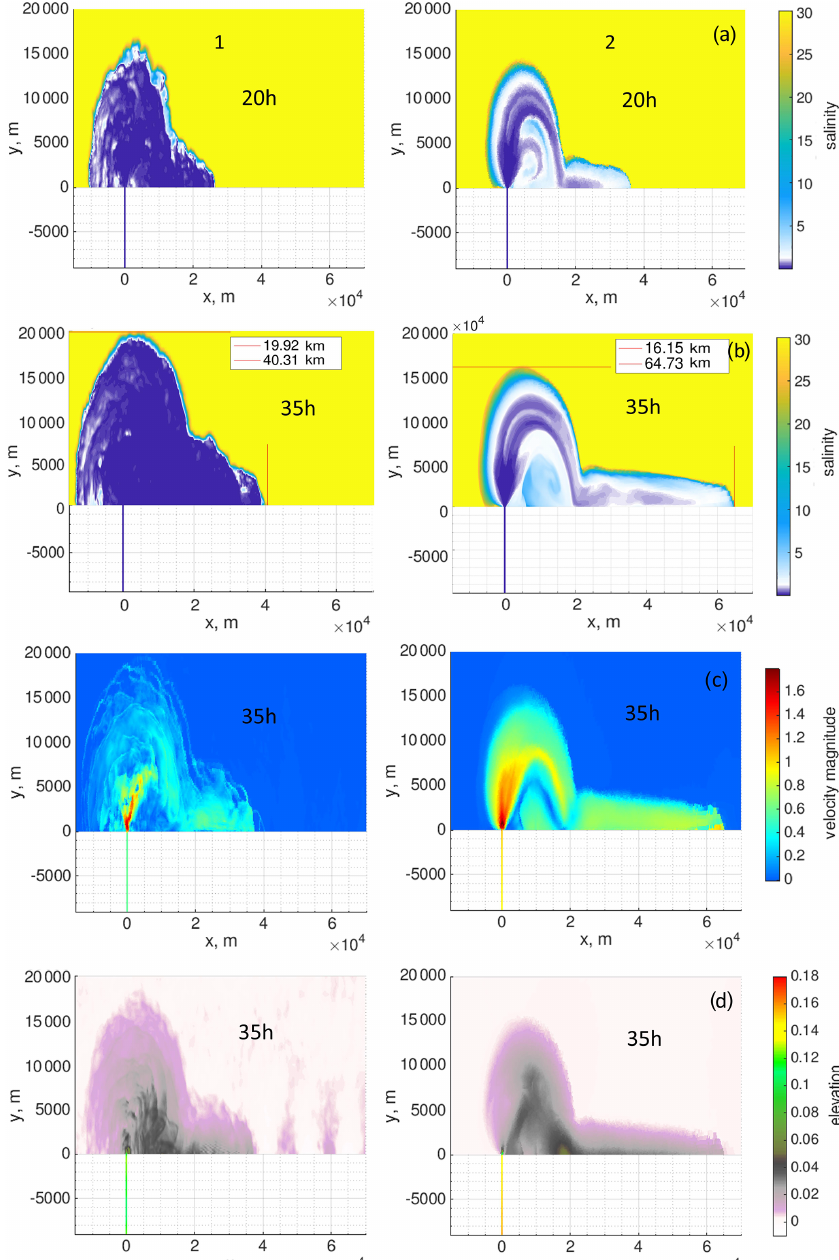
Figure 3. Results of runs 1 (left panels) and 2 (right panels) after 20 and 35h: (a) surface salinity, in practical scale, at 20h; (b) surface salinity, in practical scale, at 35h; (c) surface velocity (ms − 1 ) at 35h; (d) surface elevation (m) at